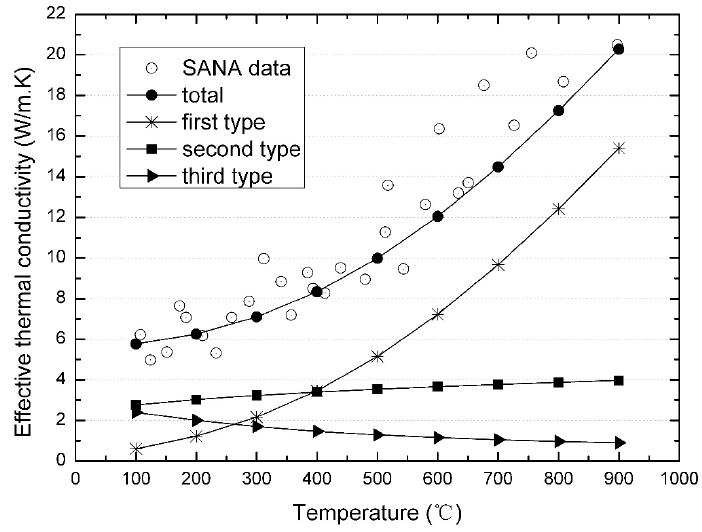
Figure 6. Total effective thermal conductivity and the experimental data of the pebble bed in SANA experiment under helium conditions.